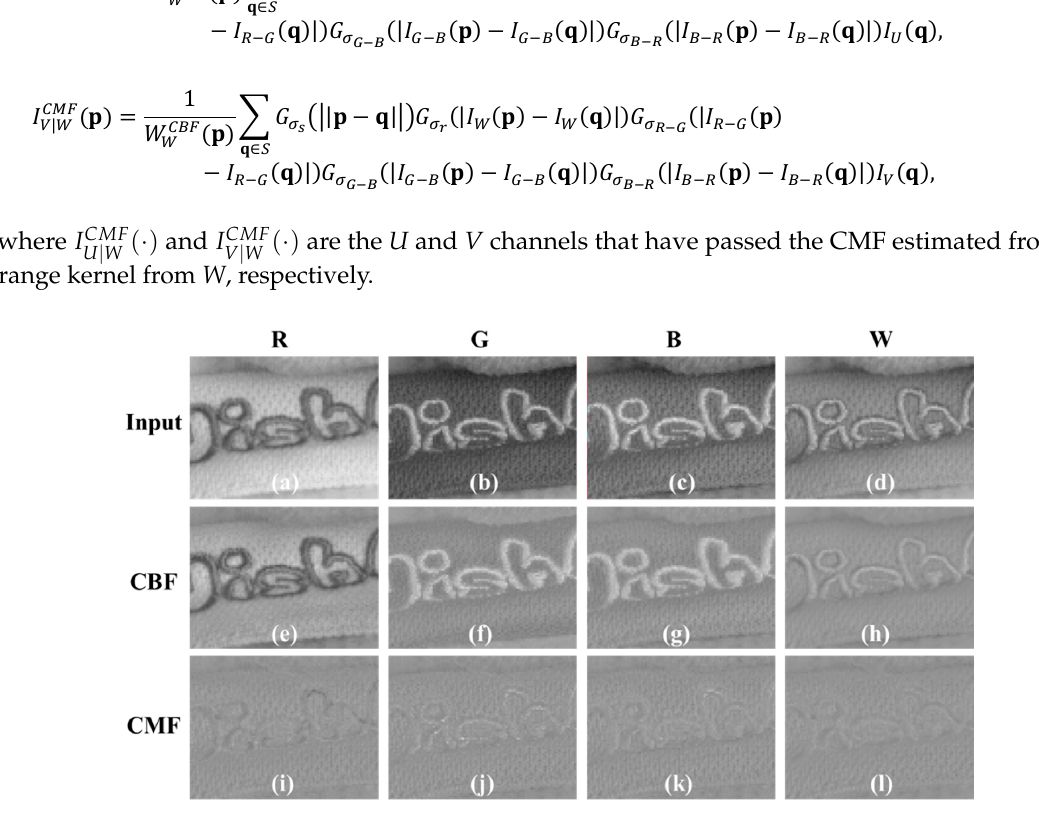
Figure 10. Results of post-processing using CBF and CMF; ( a , d ) Sony RGBW CFA demosaicing results [24]; ( b , e ) results of post-processing using CBF; ( c , f ) results of post-processing using CMF.